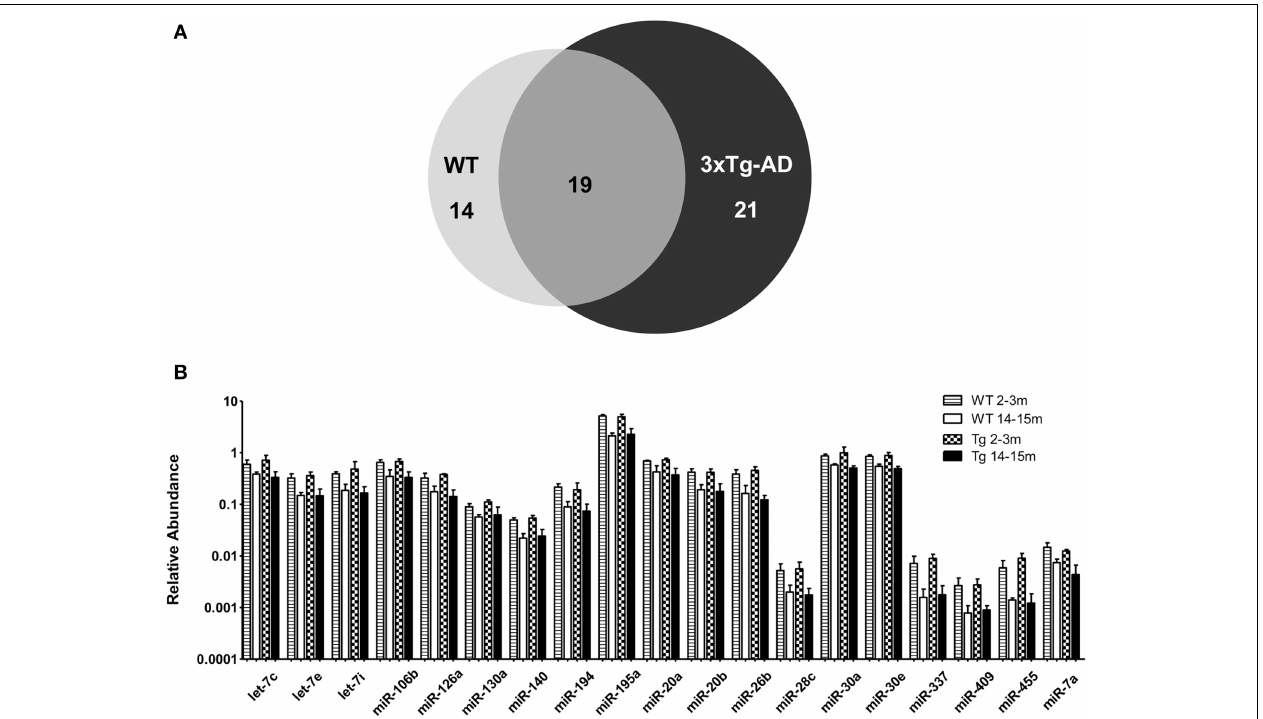
FIGURE 2 | Significant age-related changes in plasmatic miRNAs in WT and 3x-Tg-AD analyzed by qRT-PCR. (A) The Venn diagram depicts the number of miRNAs showing statistically different plasma levels between young and old mice in WT (33 miRNAs, in light gray) and in 3xTg-AD mice (40 miRNAs, in black) as shown by a t -test; p < 0 . 05. From these miRNAs, 19 are common to both comparisons (dark gray). (B) Relative abundance among